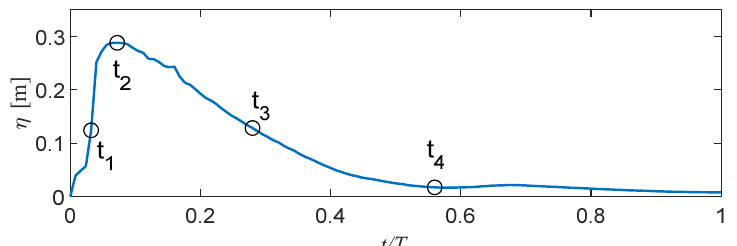
Figure 6. Time history of water surface elevation in front of the structure.